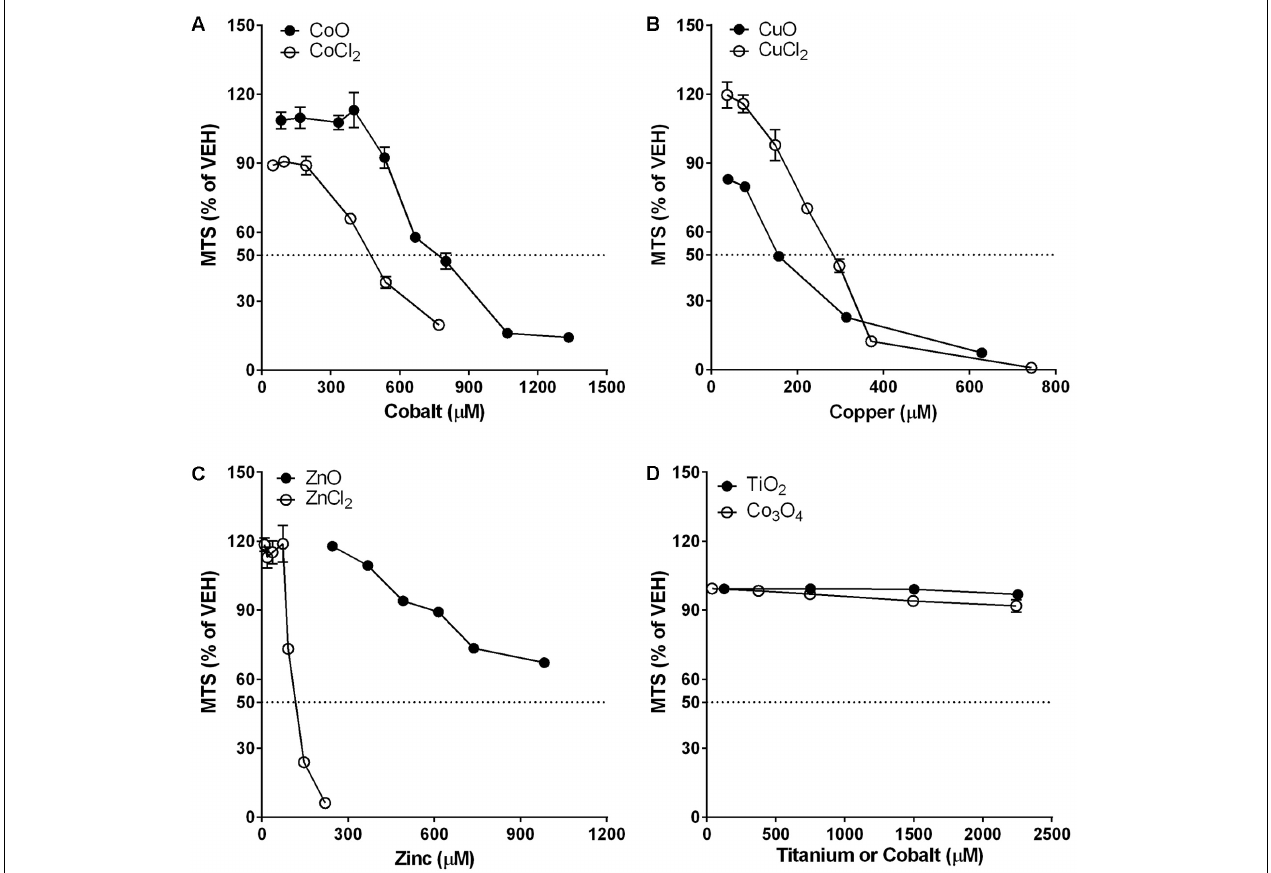
FIGURE 2 | Comparison of dose-response curves of metal-oxide NPs and their respective constituent metal chlorides in differentiated THP-1 cells. Cytotoxicity was measured by MTS assay. Note that the mass doses were converted into molar concentrations. (A) CoO NP showed a similar trend in the dose-response curve but less cytotoxic potential than CoCl 2 . (B) CuO NP showed a similar trend in the dose-response curve but higher cytotoxic potential than CuCl 2 . (C) ZnO NP showed a completely different trend in the dose-response curve with much less cytotoxic potential than ZnCl 2 . (D) Biopersistent TiO 2 and Co 3 O 4 NPs showed no cytotoxicity within the tested doses ( < 180 µ g/mL; 2254 µ M for TiO 2 and 2243 µ M for Co 3 O 4 ). Values are mean ± SEM from eight independent experiments.